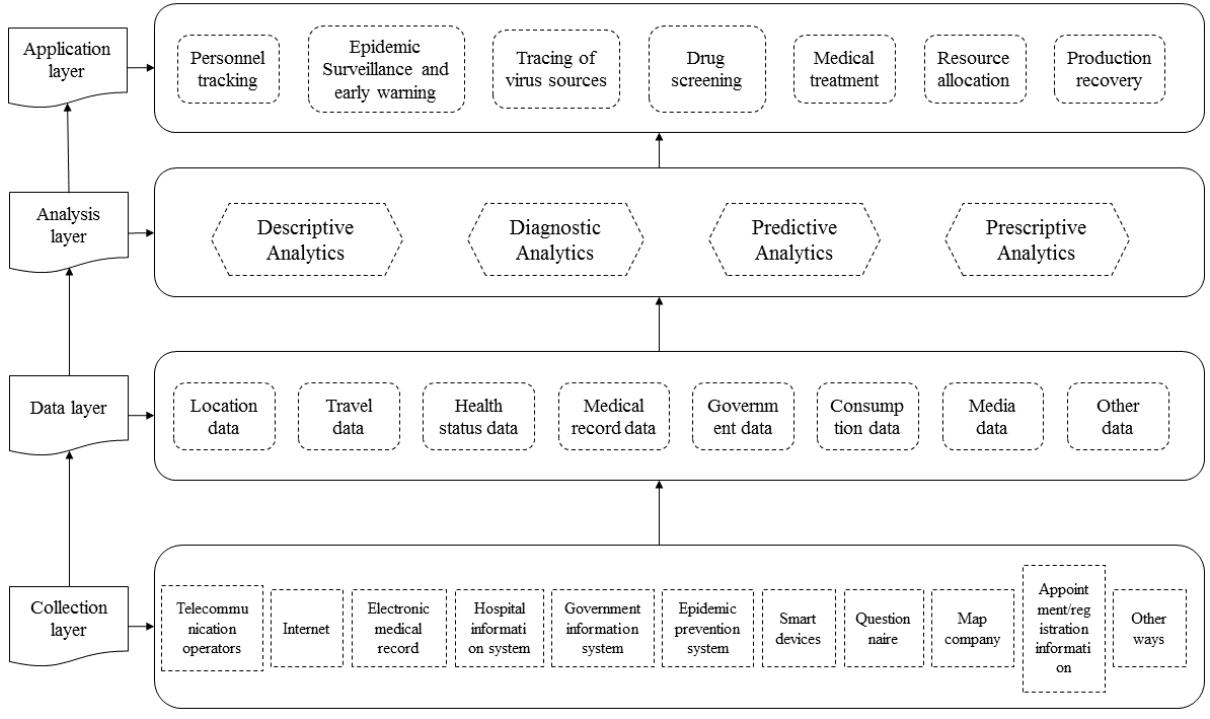
Figure 1. Conceptual structure chart of prevention and control of COVID-19 with big data